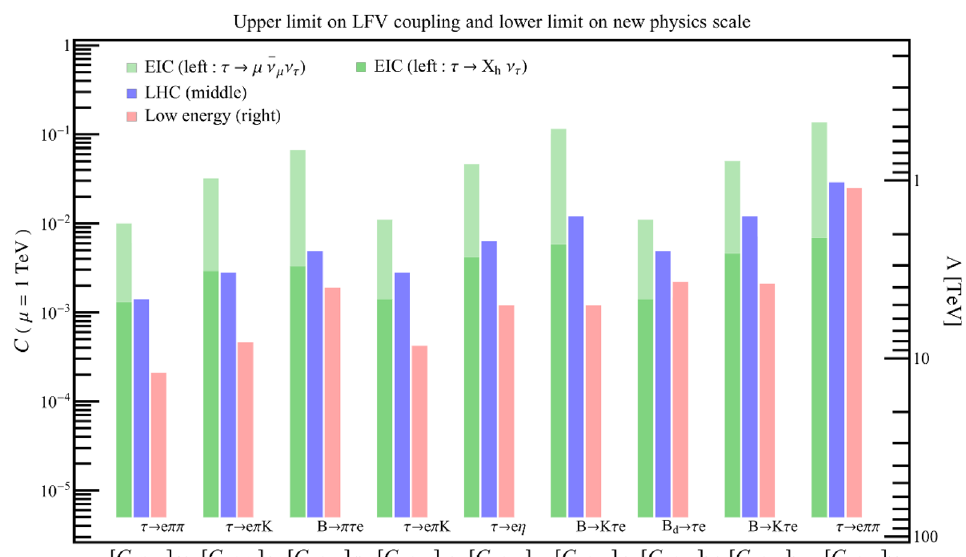
Figure 15 . Upper limit on C LQ,D (leftmost axis) and lower limit on new physics scale Λ (rightmost axis). For the EIC expected sensitivity, the light green bar corresponds to the result in table 7, while the dark green one represents the case in hadronic tau decay mode assuming (cid:15) n b = 0 in tables 3–5.